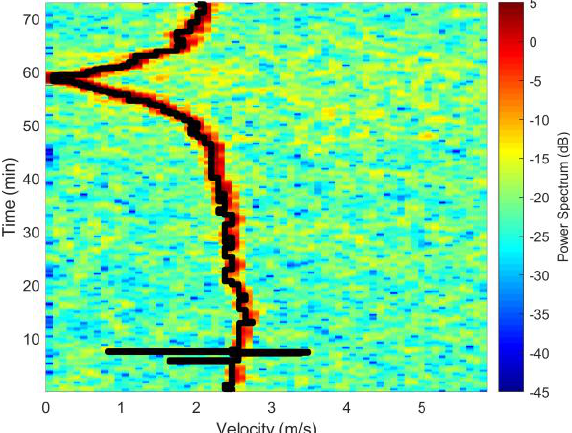
Figure 11. Estimated source velocities versus time.